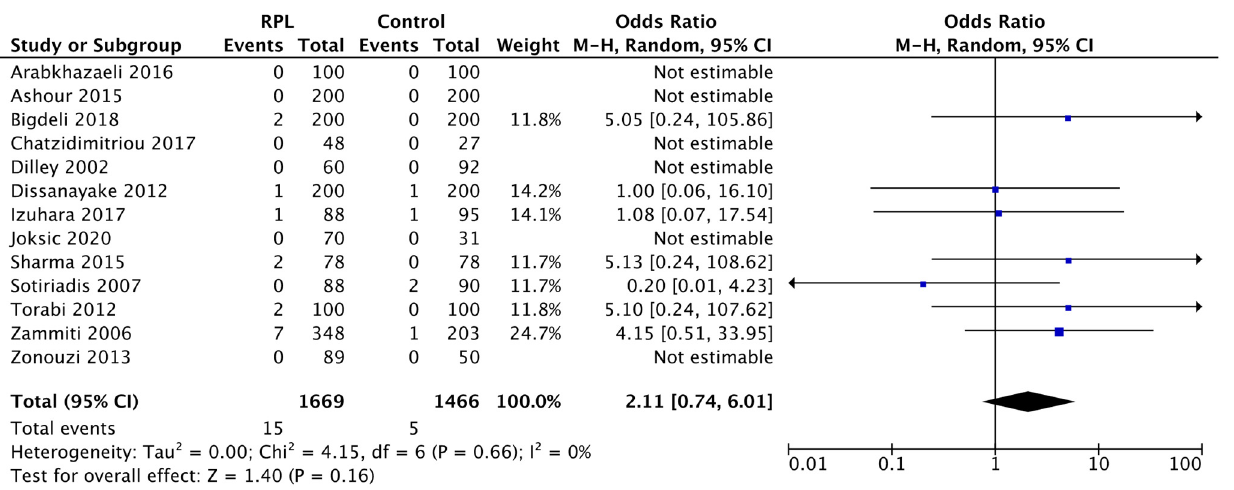
Figure 5. Forest plot of the association between H1299R homozygous and RPL. The forest plot illustrates the 95% CI for each study (black lines); the weight of each study (blue square) and the overall result (black diamond). Heterogeneity is expressed as I 2 measure. Overall effect OR: 2.11 [0.74, 6.01]; p = 0.16.